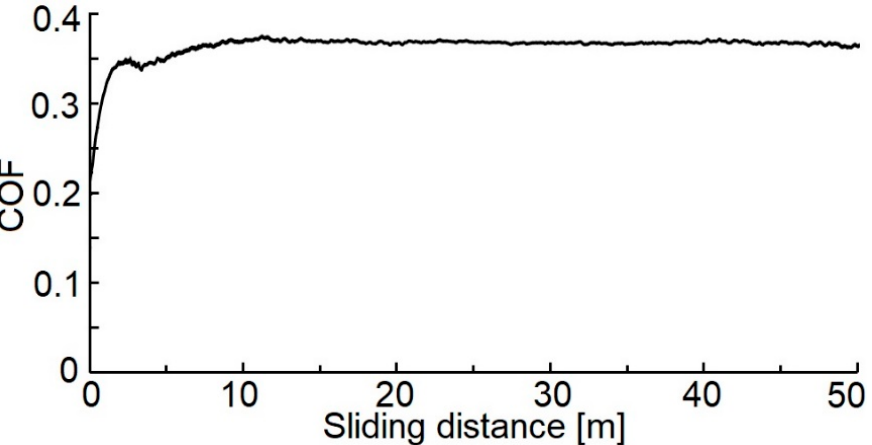
Figure 10. The COF values vs. the sliding distance of the tested WC/C coating. If we compare the measured COF values of and the WC/C coatings deposited with the N 2 -SiH 4 gas mixture using the DCMS (0.28 ± 0.03) [8] and RFMS (0.23 ± 0.02) [17] meth- ods, it can be said that our measured value of COF increased by ca. 30%. In contrast, after the applied annealing process at a temperature of 200 °C, the COF value increased slightly to 0.36 ± 0.03 (Figure 11).